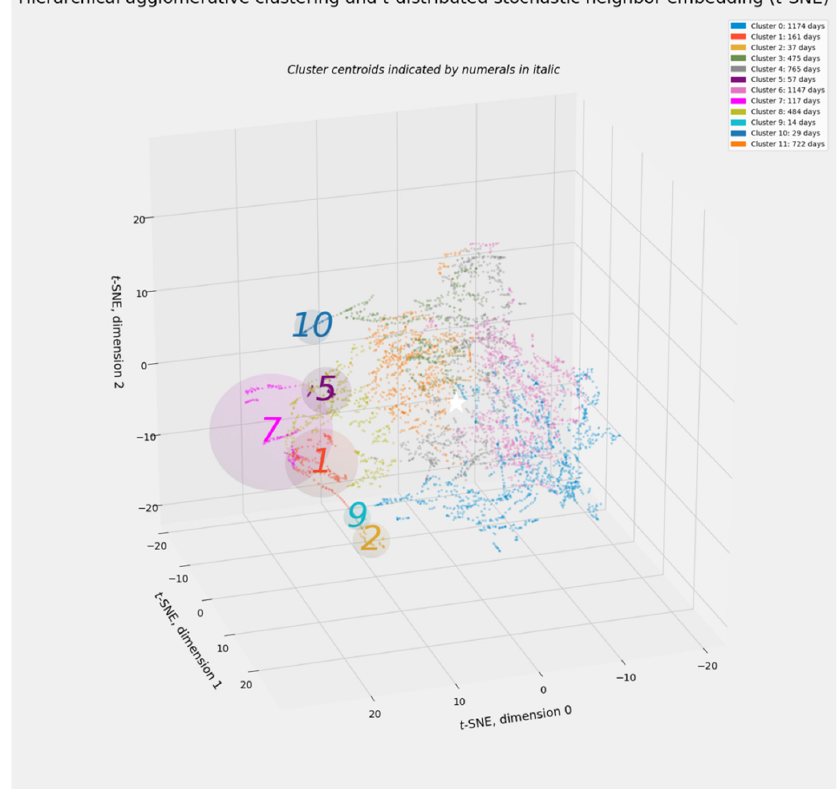
Figure 26. Hierarchical agglomerative clustering of energy-related markets—the t -SNE manifold revisited, with clusters of interest indicated by their